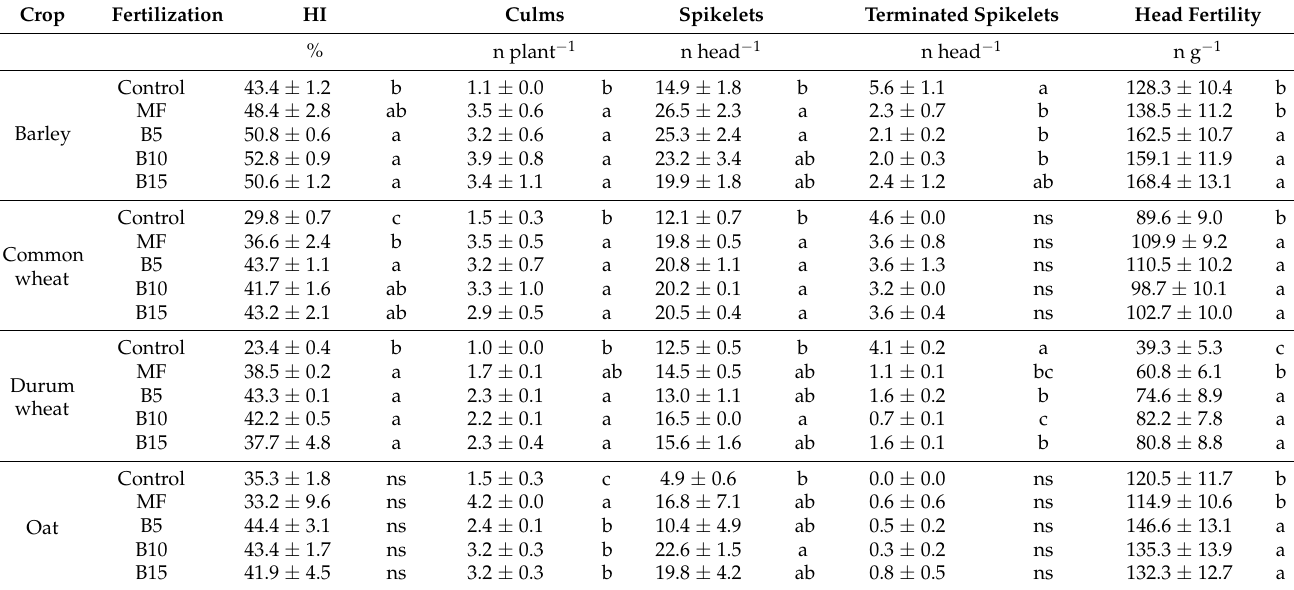
Table 5. Harvest index, number of culms, spikelets, and terminated spikelets per plant; head fertility, as affected by fertilization treatment in barley, common wheat, durum wheat, and